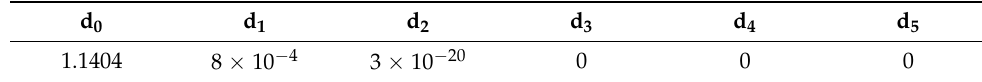
Table 3. Constants for the damage model parameters.